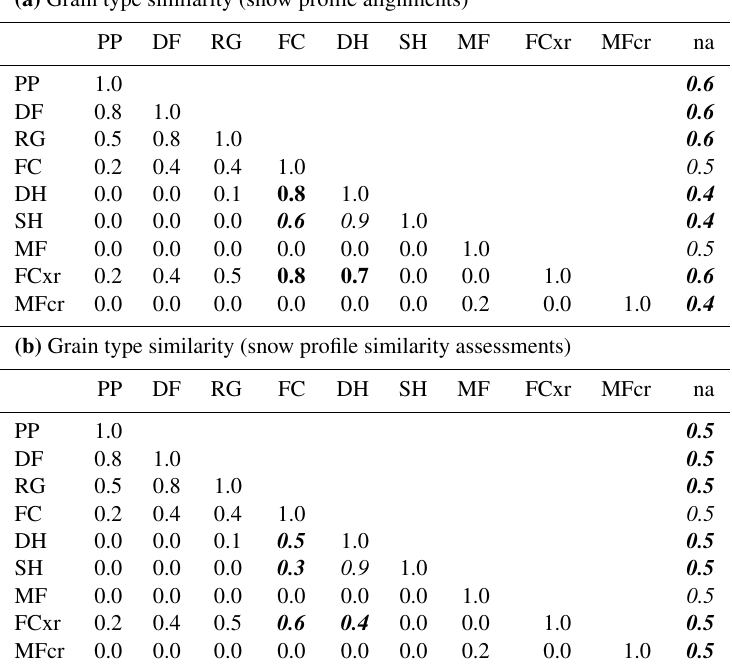
Table 1. Similarities between snow grain types as used for the layer alignment of snow profiles (a) and as used for the similarity assessment between snow profiles (b) . Italic font represents modifications introduced by this publication, bold font highlights differences between the two tables (a) and (b) , and all other values are taken directly from Lehning et al.